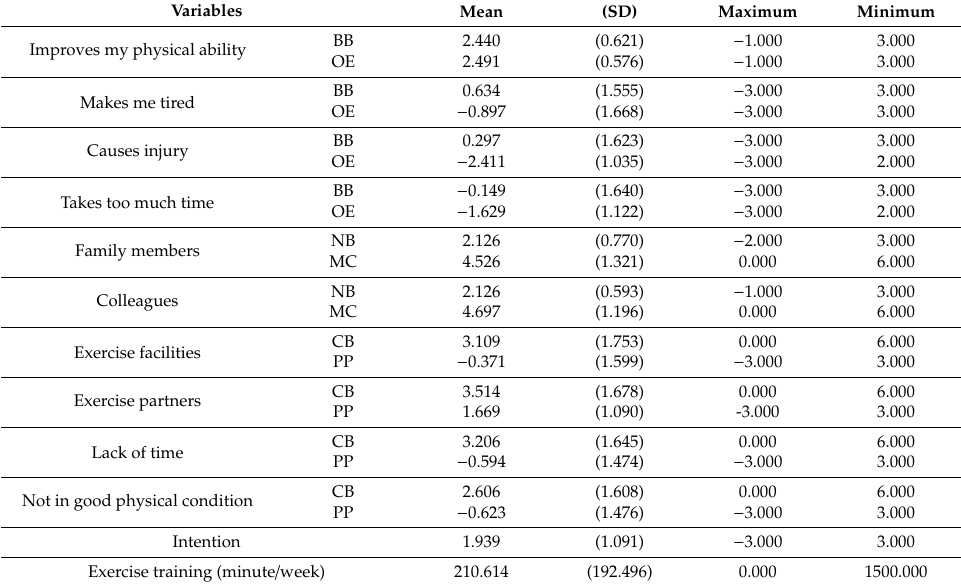
Table 1. Descriptive statistics for participants ( N =